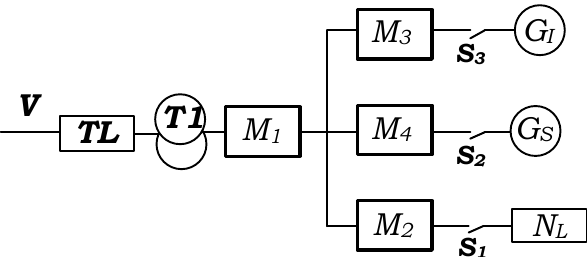
Figure 6. Illustration of the proposed interconnected power